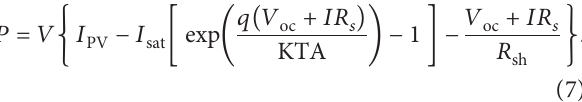
Figure 9: Simulated P-V plot of varying R